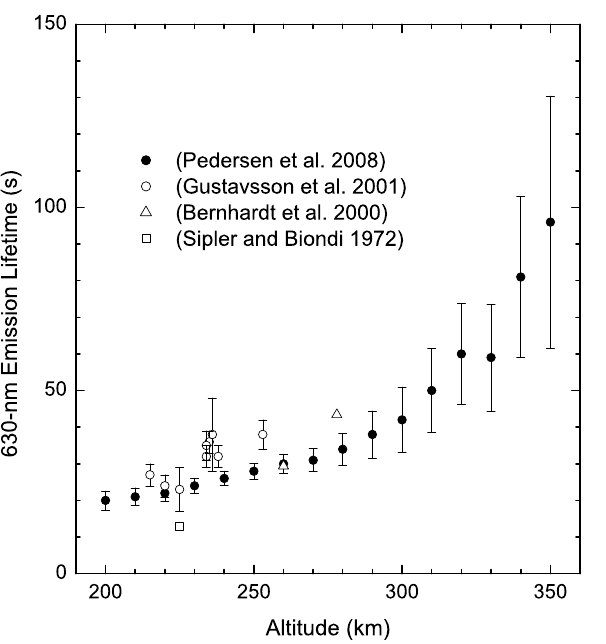
Fig. 2b. Observed and calculated O( 1 D) lifetimes for the HAARP data set (solid black circles). The solid grey line, dashed grey line, and solid black line represent the calculated values, as deduced from Eq. (1), for different values of k O . The black dotted lines accompa- nying the black solid line reflect the range of lifetime values calcu- lated for an estimated 15% uncertainty in the rate